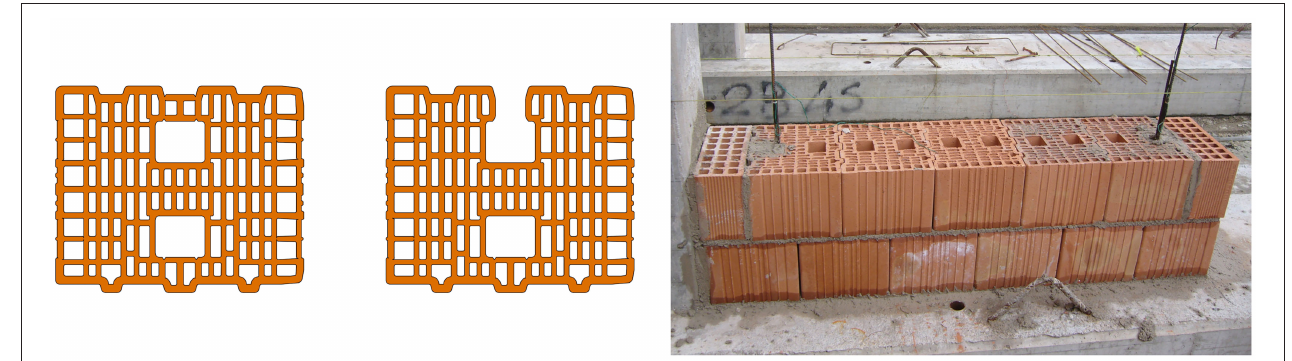
FIGURE 1 | Clay unit of the construction system (left) ; example of reinforced masonry infill wall construction (right) .